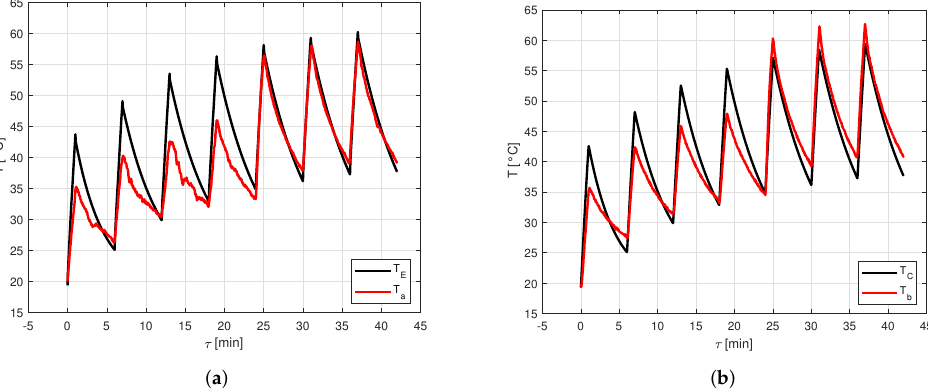
Figure 8. Comparison between numerical data computed through the model and experimental data acquired by the thermocouples for the seven thermal cycles. ( a ) Comparison between T a and T E . ( b ) Comparison between T b and T C